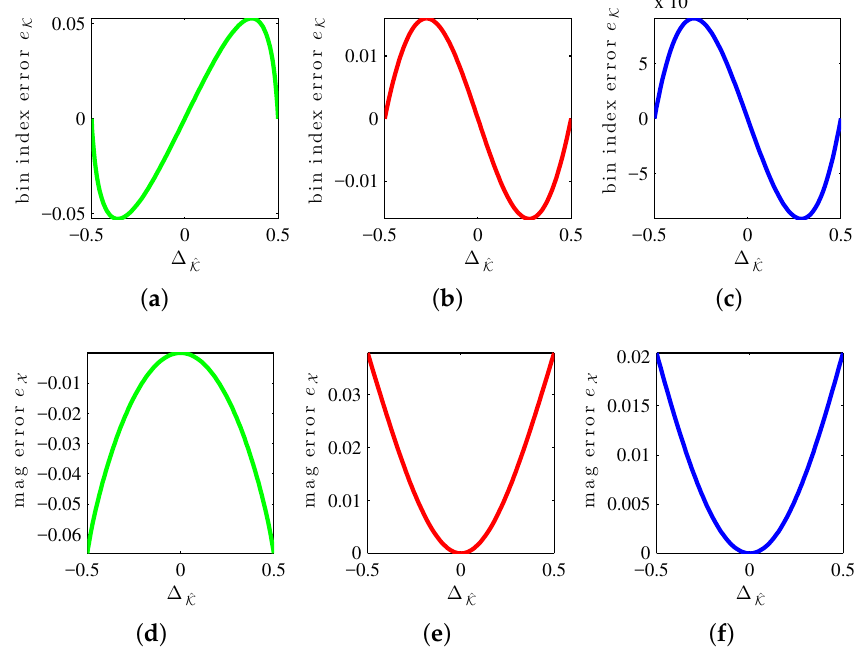
Figure 4. Correction curves. ( a ) MQIFFT; ( b ) LQIFFT; ( c ) XQIFFT, p = 0.1; ( d ) MQIFFT; ( e ) LQIFFT; ( f ) XQIFFT, p =